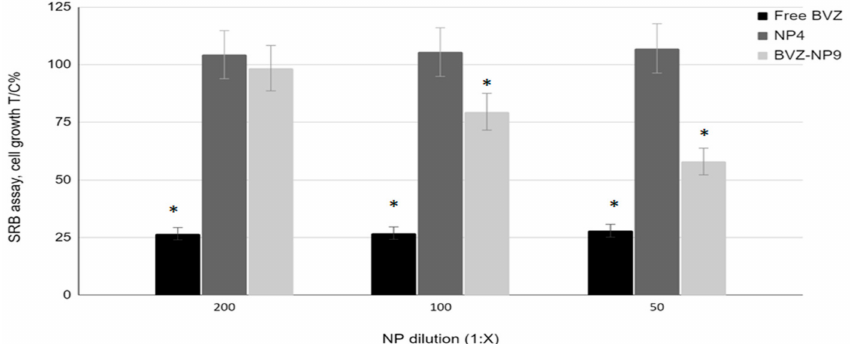
Figure 8. Effect of BVZ, NP4 (blank NP), and NP9 (BVZ-NP) on ARPE-19 cell proliferation after 72 h of incubation. On the X -axis, the NP dilutions 1:200, 1:100, and 1:50 correspond to 5, 10, and 20 µ g/mL BVZ concentrations. Blank NP4 was diluted as NP9. Free BVZ was diluted appropriately to obtain the same BVZ concentration. The cell growth is expressed as % T/C (mean OD of treated cells/mean OD of control cells × 100). Values refer to the means ± SD ( n = 3 wells/condition) of three independent experiments. Asterisks * indicate statistically significant differences of BVZ and NP9 vs. NP4-treated cells at the same concentrations (* p <